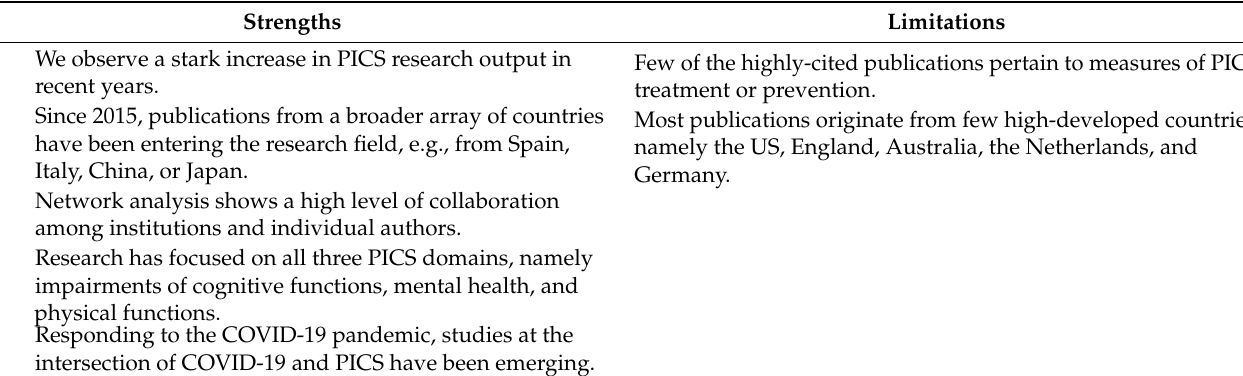
Table 7. Aspects of the current PICS research